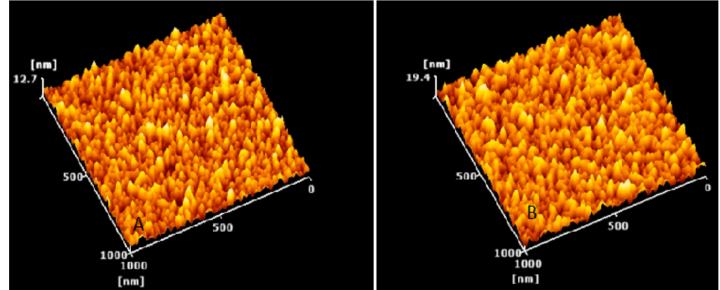
Figure 8. 3D AFM images of ( A ) placebo nanoparticles and ( B ) rotigotine-loaded nanoparticles. In both formulations, particle distribution is homogeneous and the particle shape is seen to be round shaped. Topography image 1 micrometer × 1 micrometer of the same